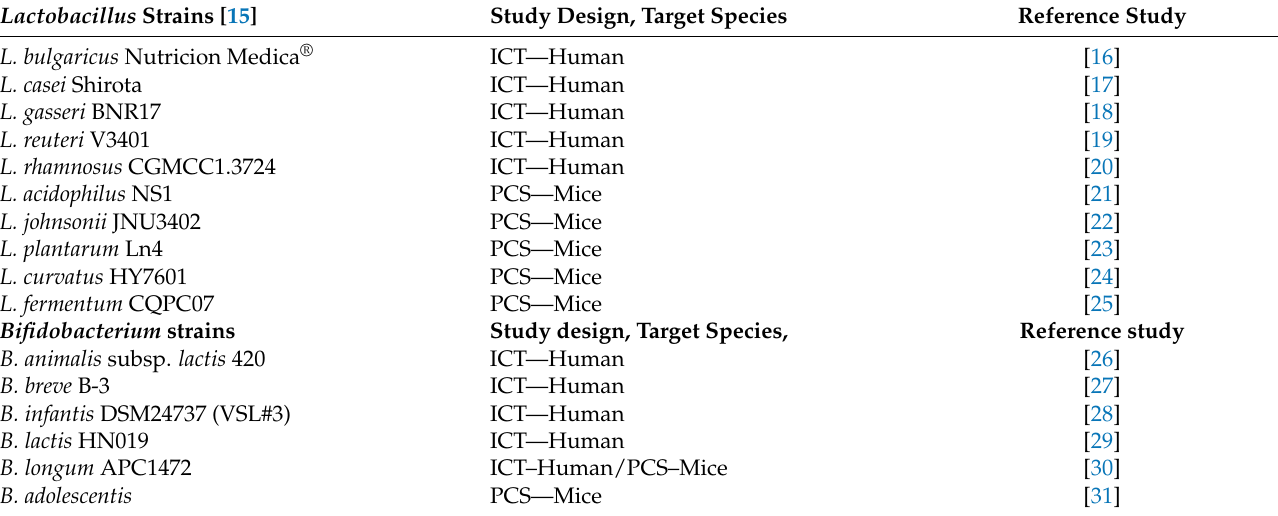
Table 1. Traditional probiotics for obesity-related interventional clinical trials and preclinical studies. Lactobacillus Strains